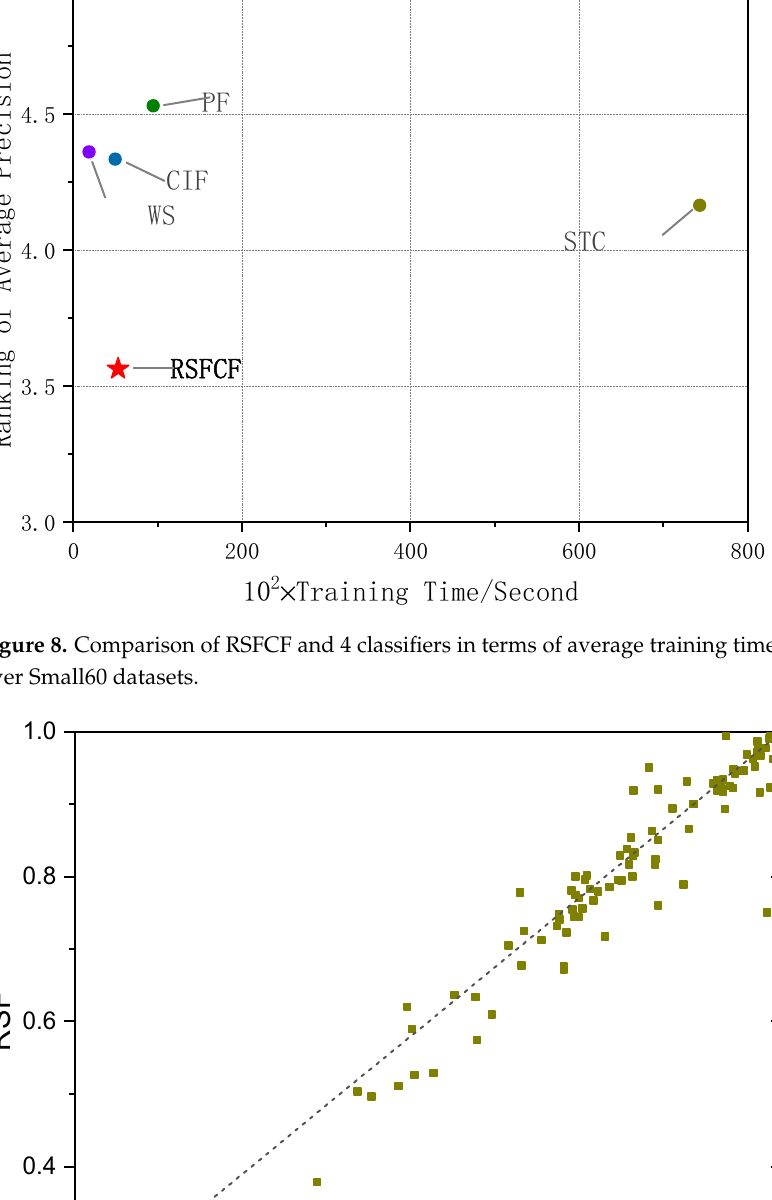
Figure 8. Comparison of RSFCF and 4 classifiers in terms of average training time and average ranks over Small60 datasets.